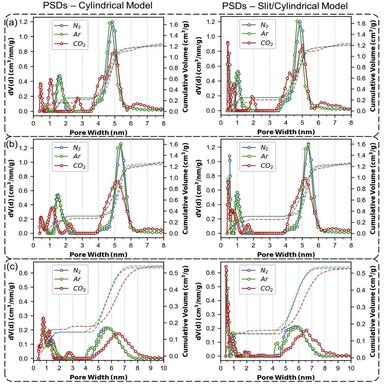
Pore size distributions for (a) CMK-3a, (b) CMK-3b, and (c) CMK-3c samples using a cylindrical pore model kernel (left column), and slit pore model for micropores and cylindrical pore model for mesopores (right column). (A colour version of this figure can be viewed online.)